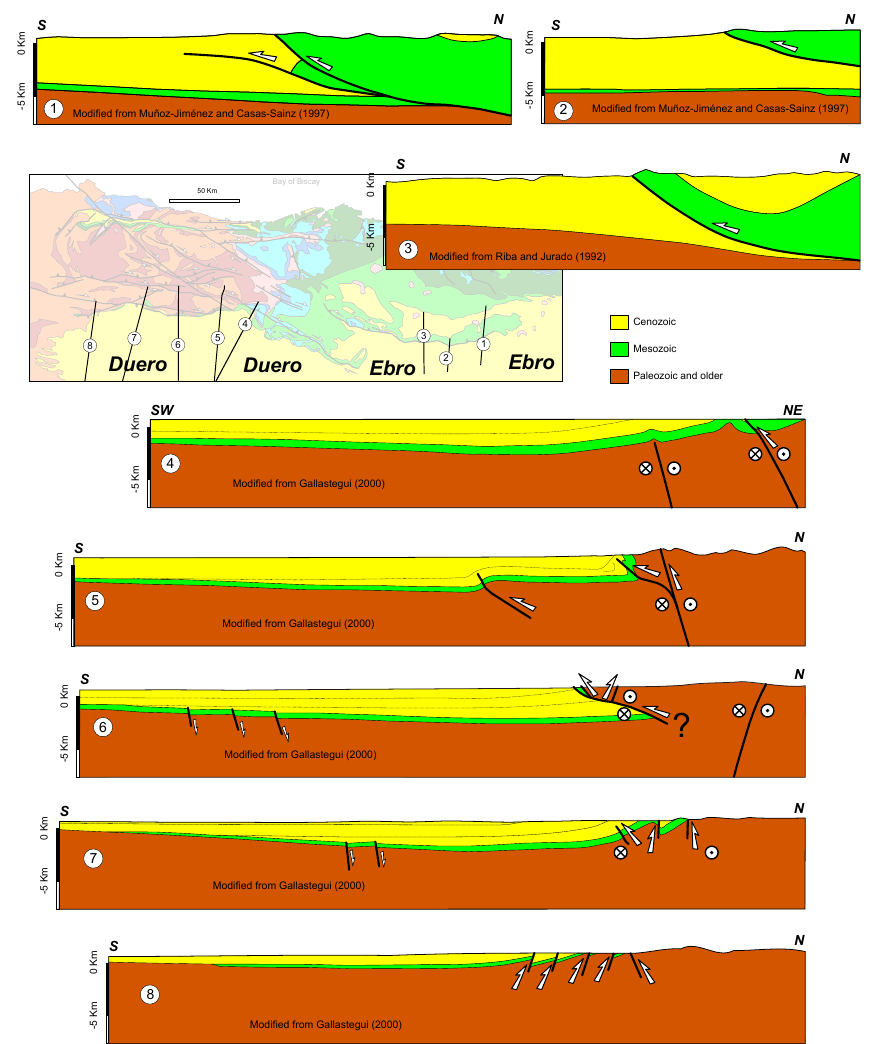
Fig. 6. Geological cross sections across the mountain front of the study